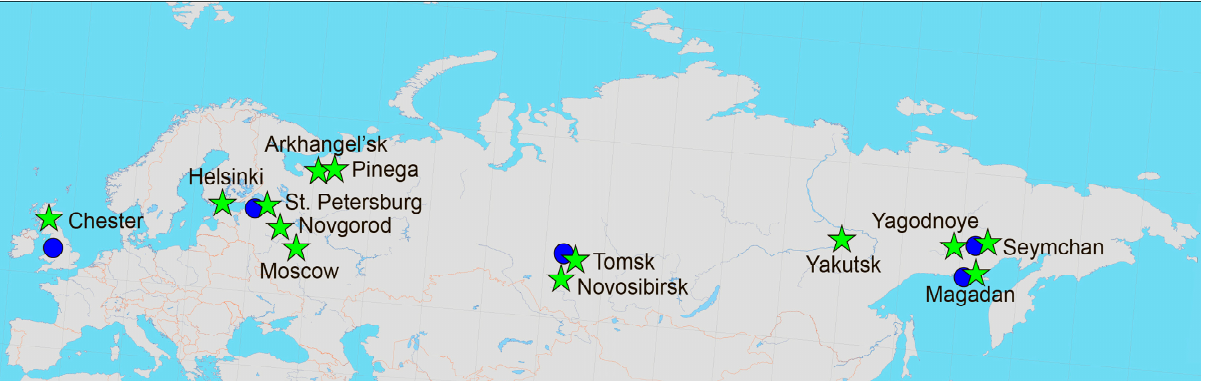
Figure 1. Locations of the Aglais urticae capture for genetic analysis (asterisks) and the determination of cold hardiness (circles). Geographical localities and the number of samples studied in the genetic analysis are indicated in Table